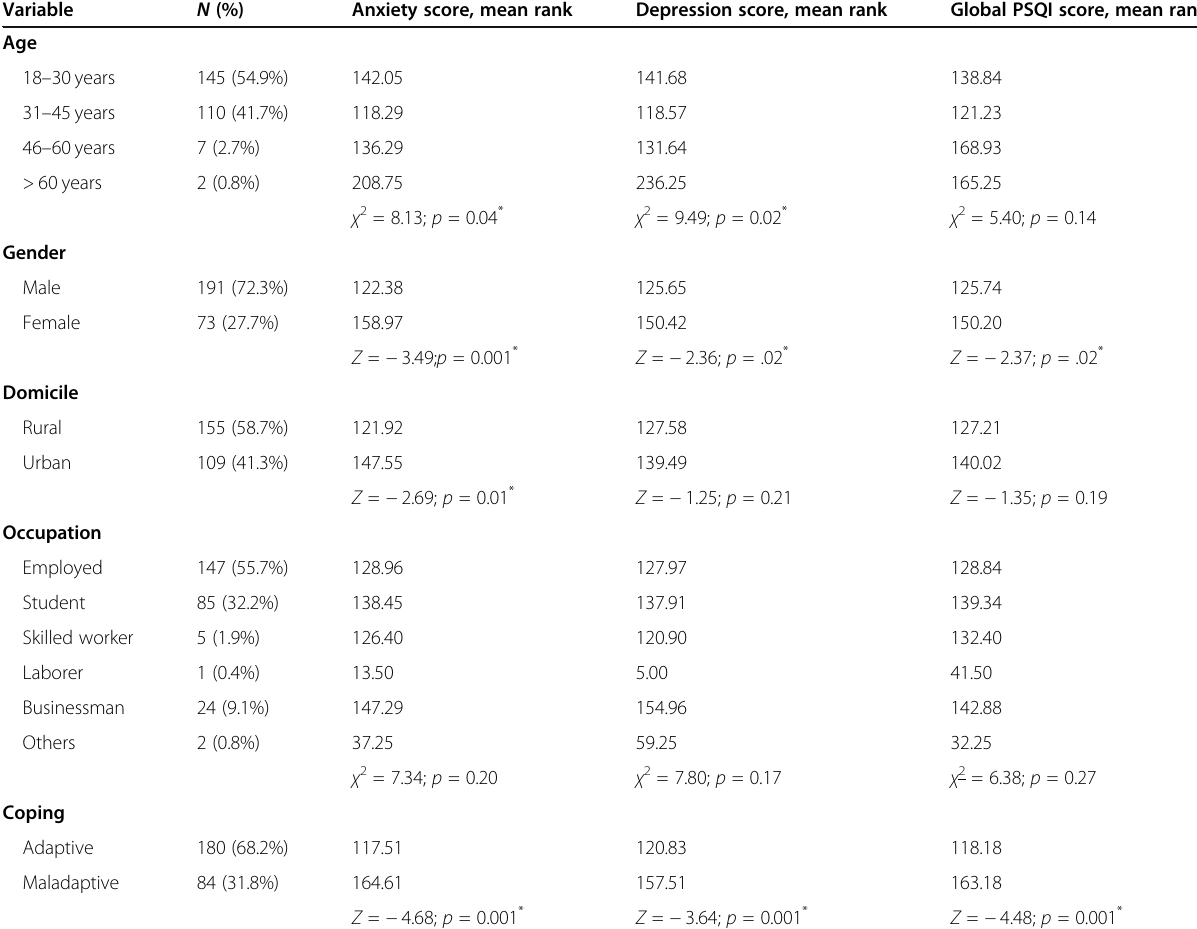
Table 5 Comparison of anxiety and depressive symptoms and quality of sleep by mean ranks ( N = 264)